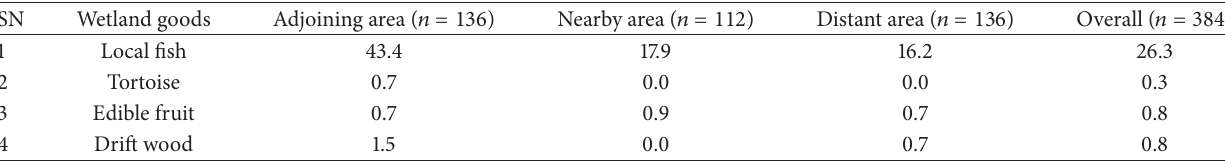
Table 4: HHs consuming different wetland goods. Unit: % of HHs.